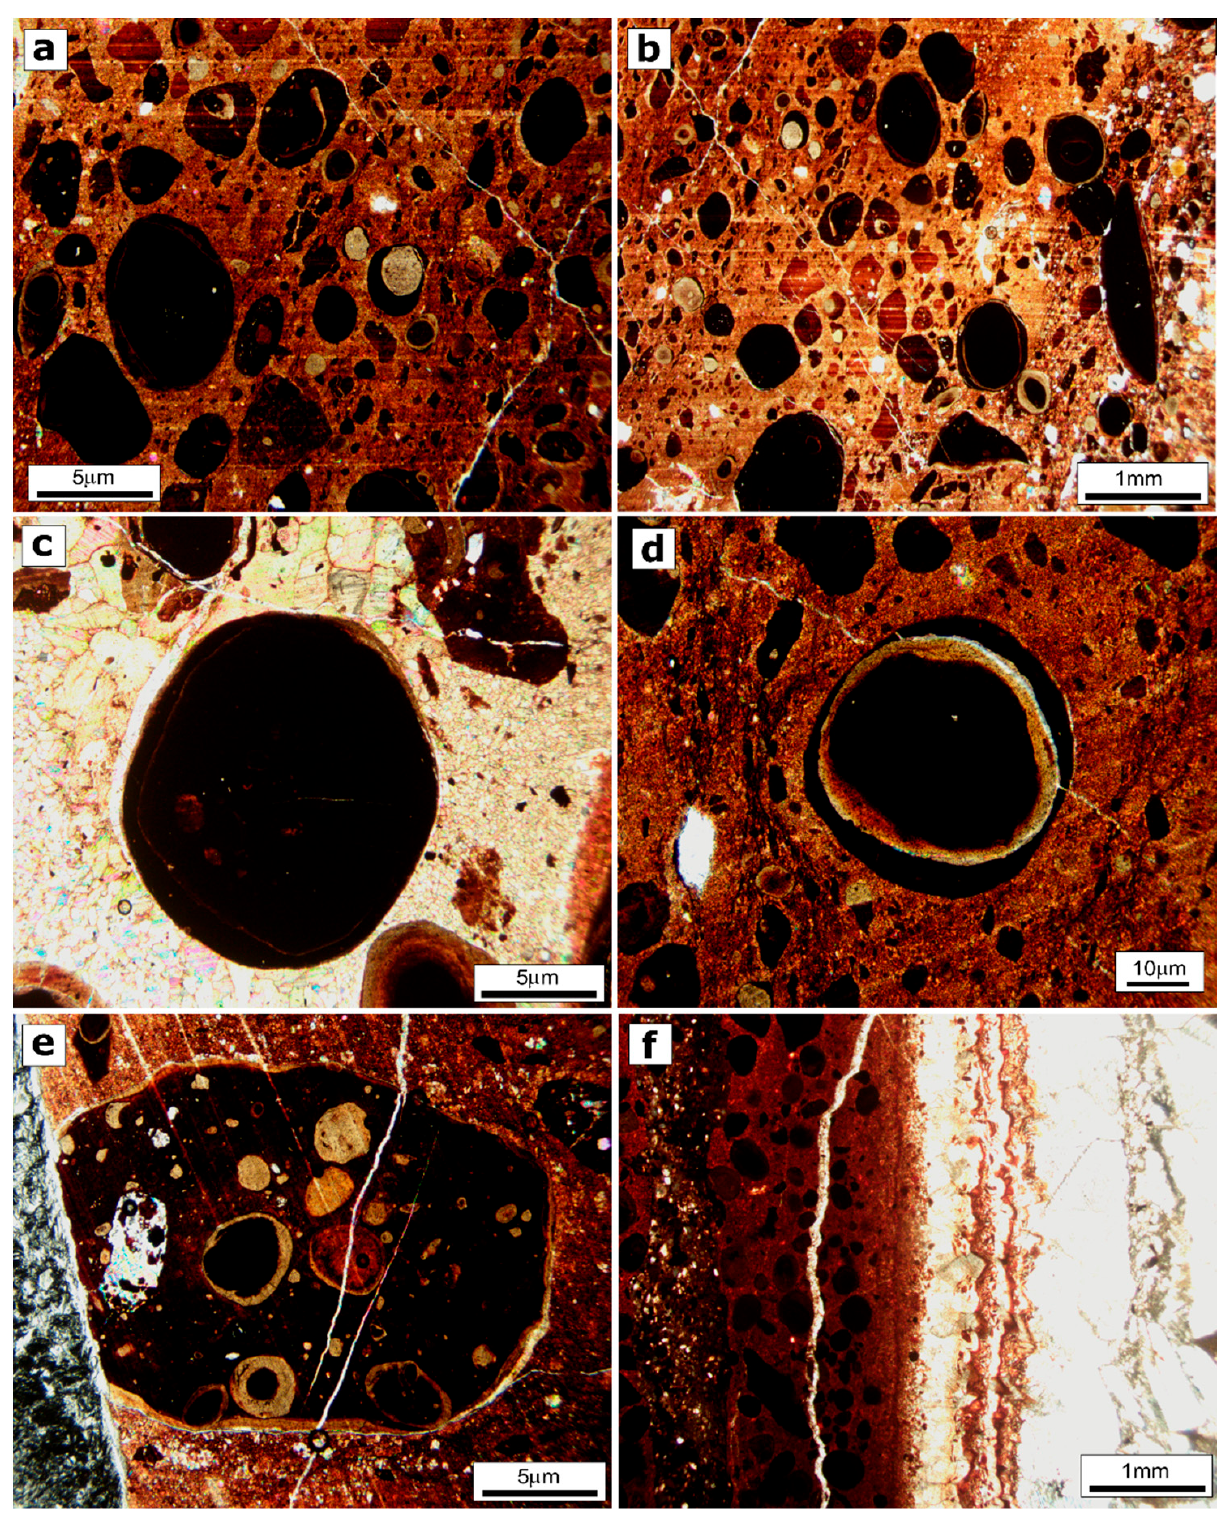
Figure 3. Petrographic observations of selected bauxite samples showing typical textural features: ( a , b ) typical texture of karst bauxites with ooids dispersed in a fine matrix; ( c , d ) larger sub-circular ooids with homogeneous mineral composition; ( e ) large bauxite fragment including several ooids and aggregates; ( f ) contact zone between bauxite and calcite vein.